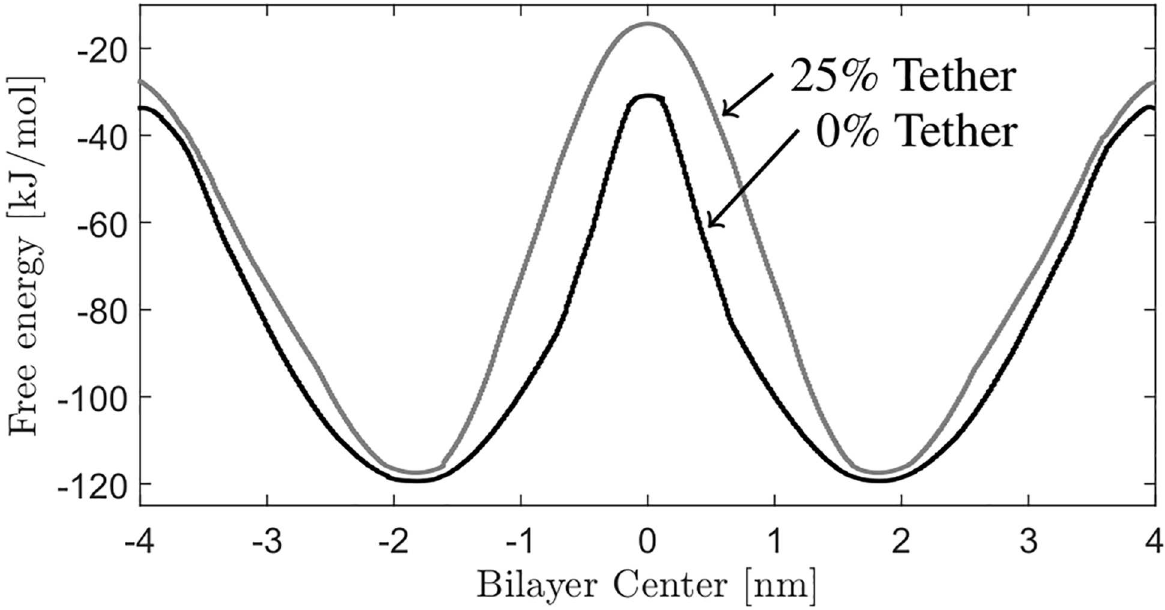
Fig 3. PMF of DphPC lipid. The PMFs for a 0% and 25% tether density DphPC lipid